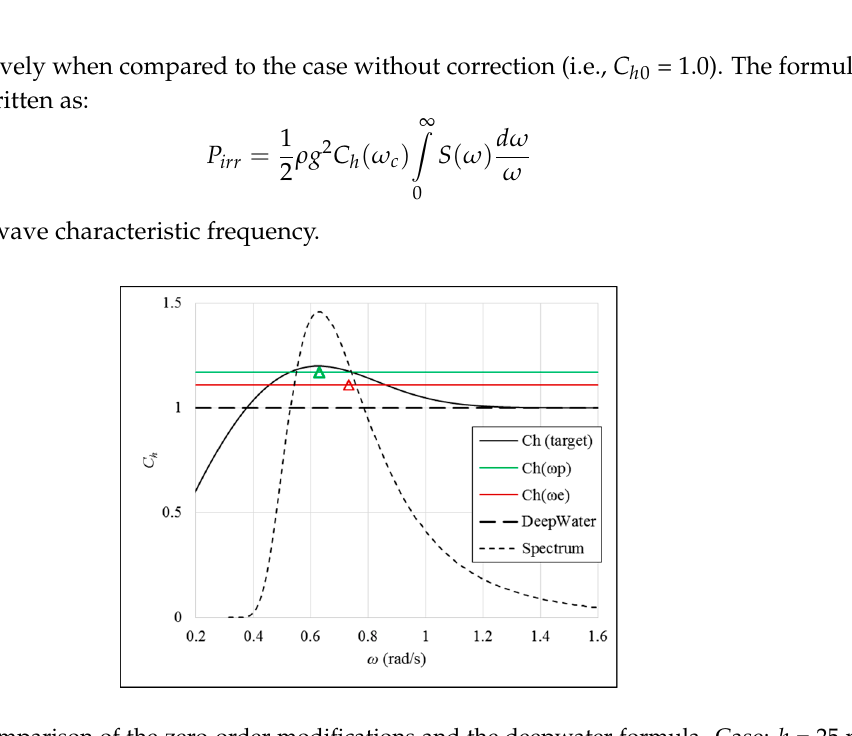
Figure 2. Comparison of the zero-order modifications and the deepwater formula. Case: h = 25 m, T p = 10 s.